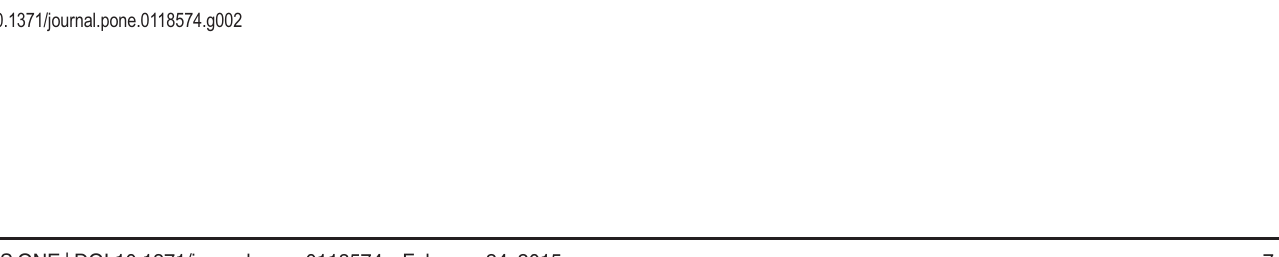
PLOS ONE | DOI:10.1371/journal.pone.0118574 February 24,